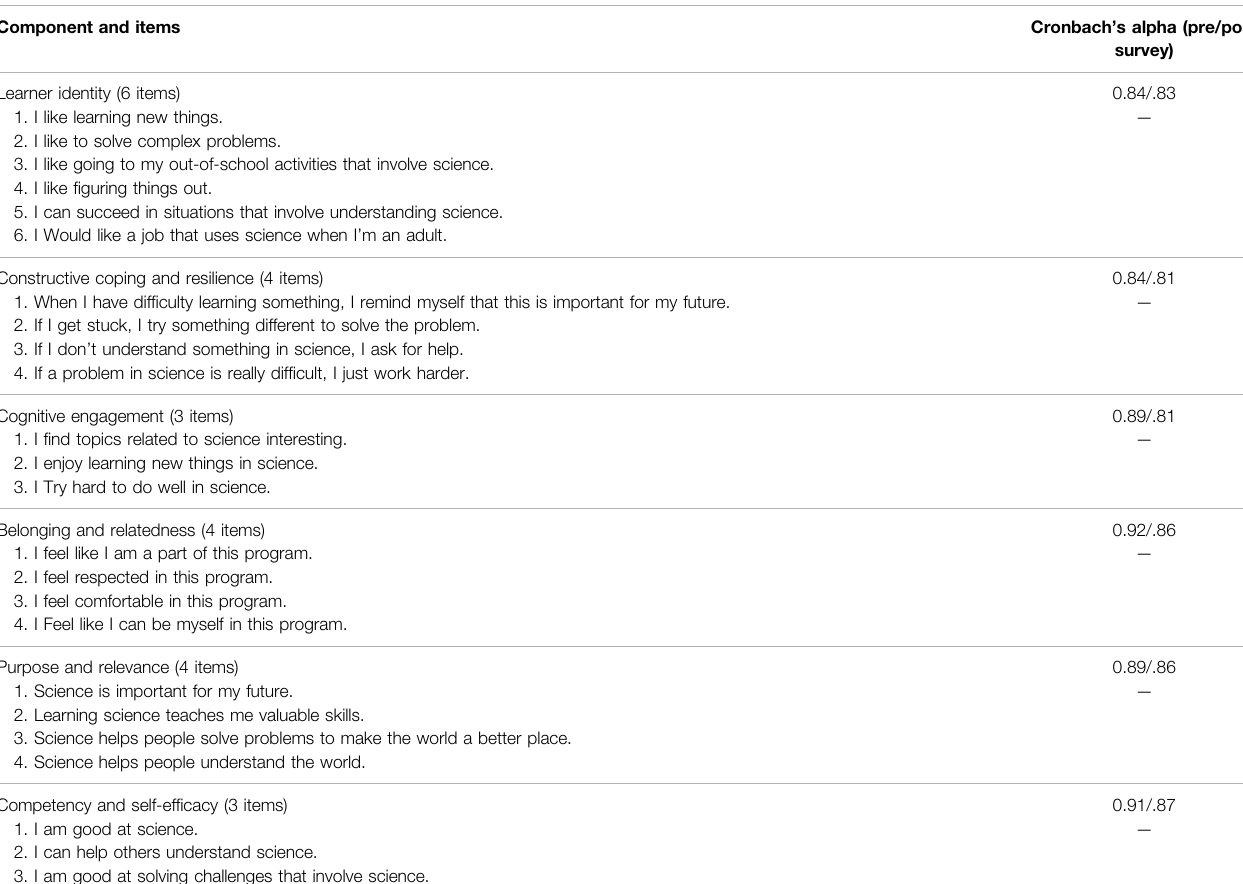
TABLE 1 | Items comprising survey components and corresponding Cronbach ’ s